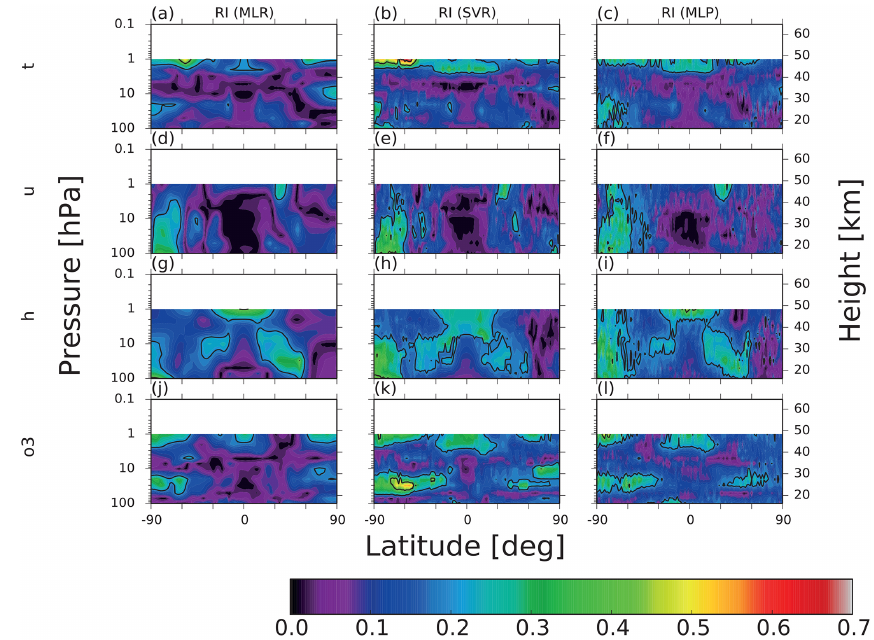
Figure 3. The annually averaged response of the solar signal in the ERA-Interim zonal-mean temperature t (a–c) , unit: K; zonal wind u (d–f) , unit: ms − 1 ; geopotential height h (g–i) , unit: gpm; and ozone mixing ratio o 3 (j–l) , unit: percentage change per annual mean. The response is expressed as a relative impact RI approach. The relative impact was modelled by MLR, SVR and MLP techniques. The black contour levels in the RI plots are 0.2, 0.4, 0.8 and